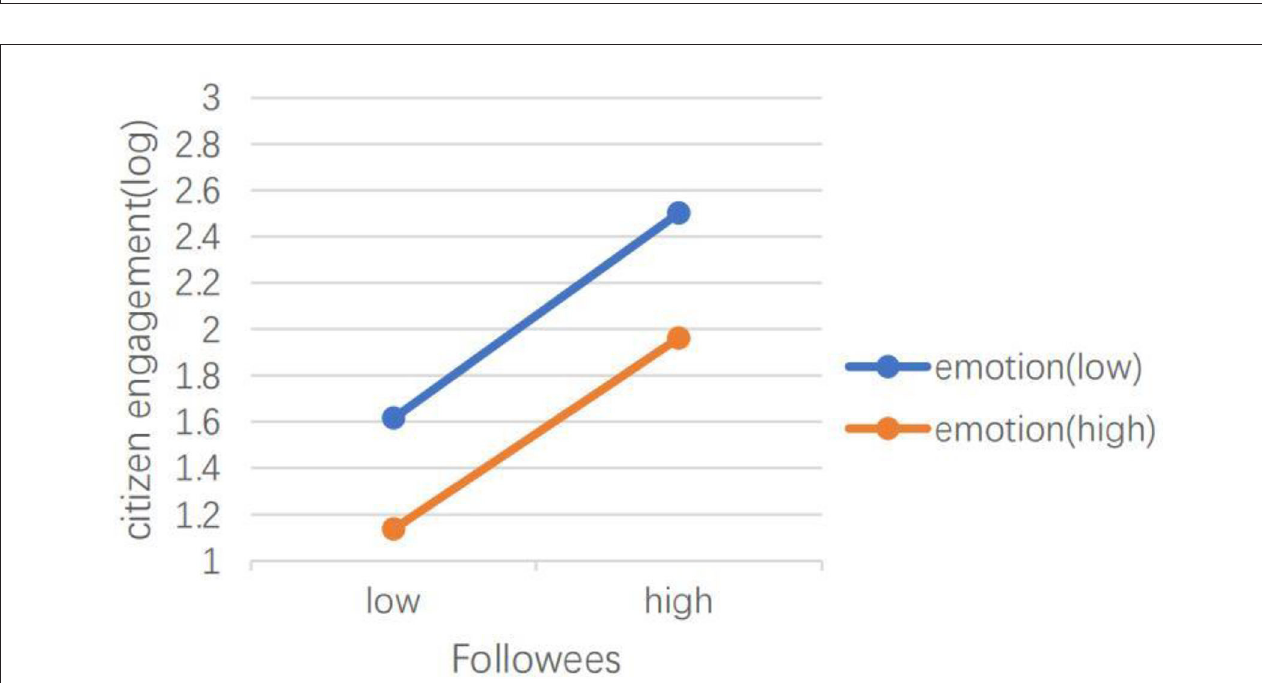
FIGURE 7 | Two-way interaction between the number of followees and emotional valence in predicting CEGSM in the case drop stage.